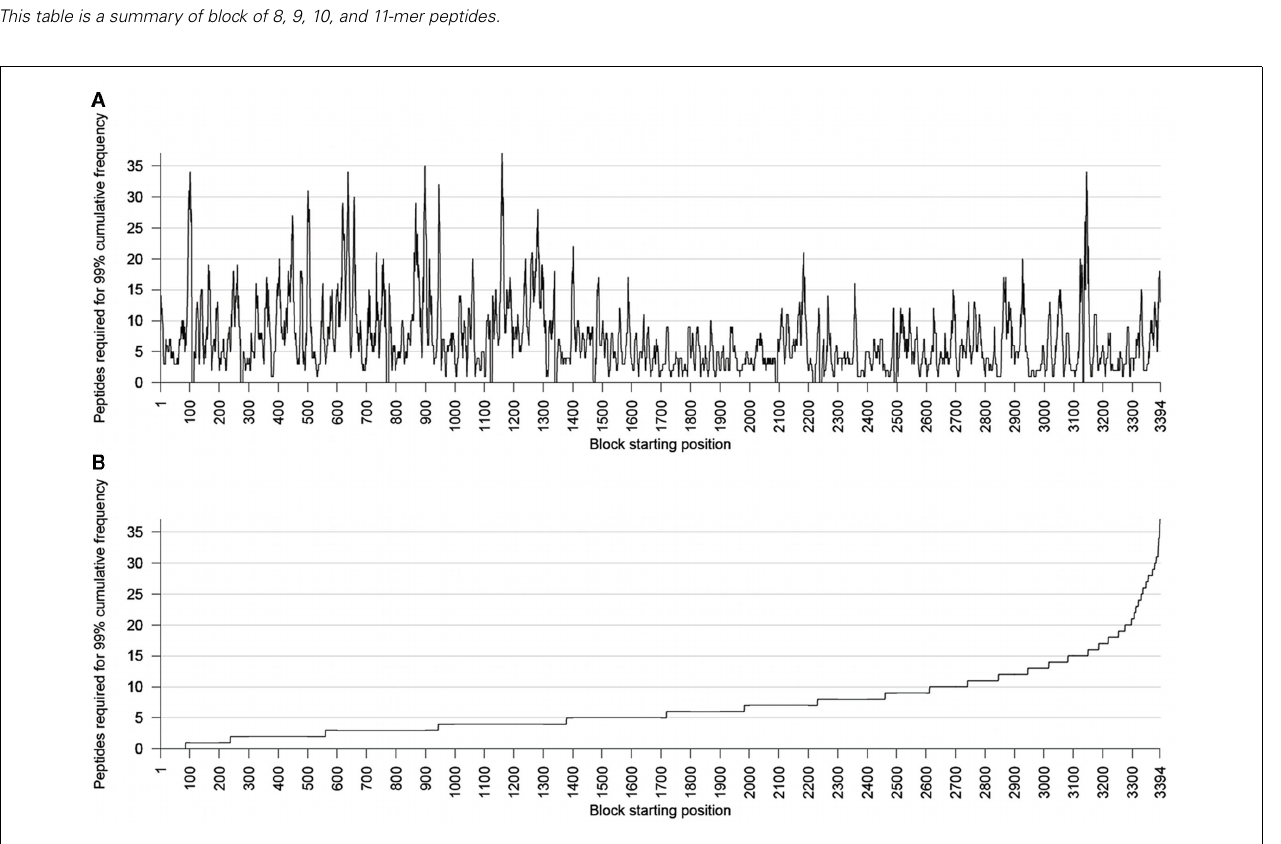
FIGURE 2 | (A) The number of 9-mer peptides required to cover 99% of a block, for each possible start position in the proteome. (B) The number of 9-mer peptides required to cover 99% of a block, sorted in increasing order.